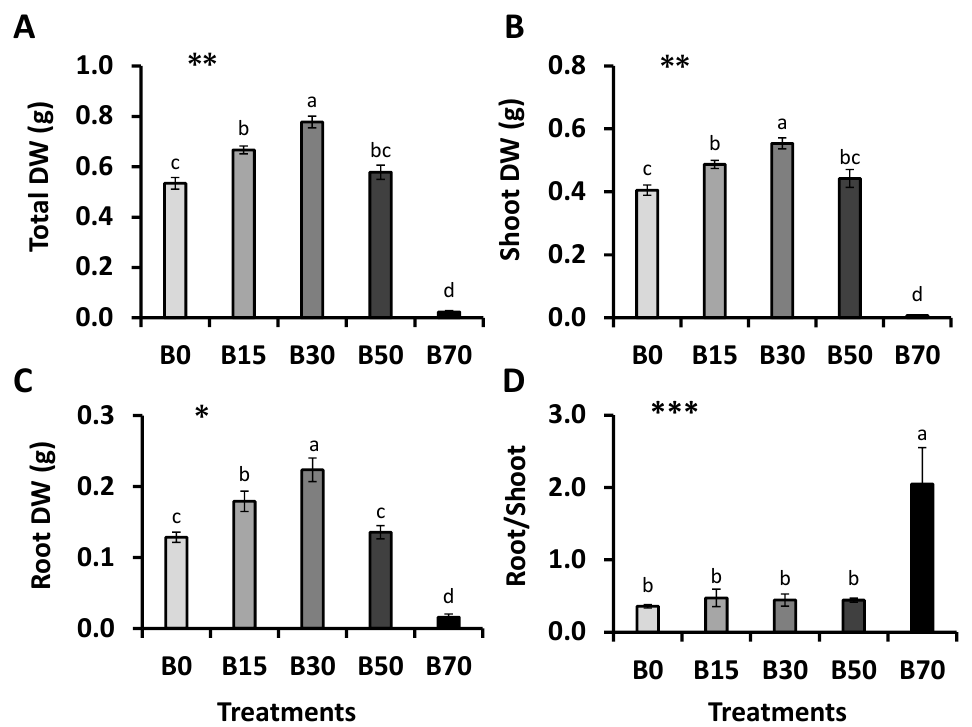
Figure 2. Growth parameters of lettuce plants cultivated under different peat:biochar substrates. ( A ) Total Dry Biomass (g); ( B ) Shoot Dry Biomass (g); ( C ) Root Dry Biomass (g); and ( D ) Root:shoot ratio (%). Values are the mean of n = 6. Values with different letters are significantly different according to Tukey’s test. Levels of significance: * p ≤ 0.05. ** p ≤ 0.01. *** p ≤ 0.001. Table 6. Water and stress-indicating parameters in lettuce plants cultivated under different peat:bi- ochar substrates. Plants grown on different biochar:peat